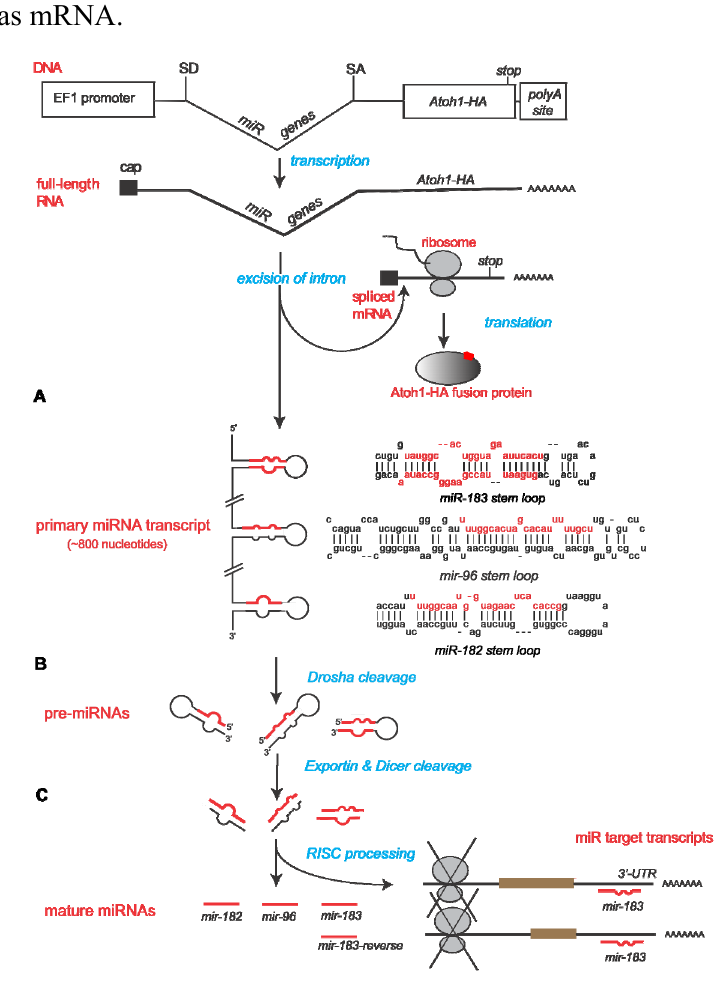
Figure 1. Bifunctional vector design and processing of transcripts. The vector consists